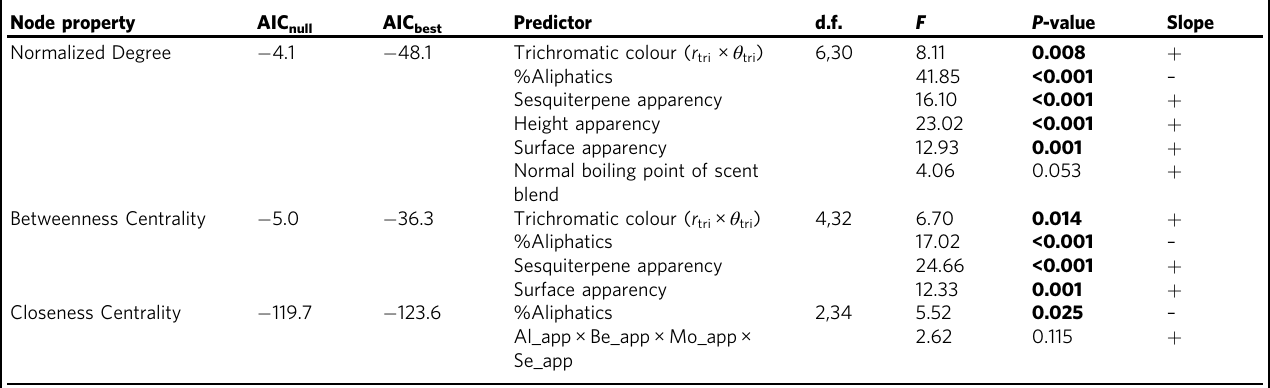
Table 1 Floral traits associated with the three node properties of plants in the network studied Node